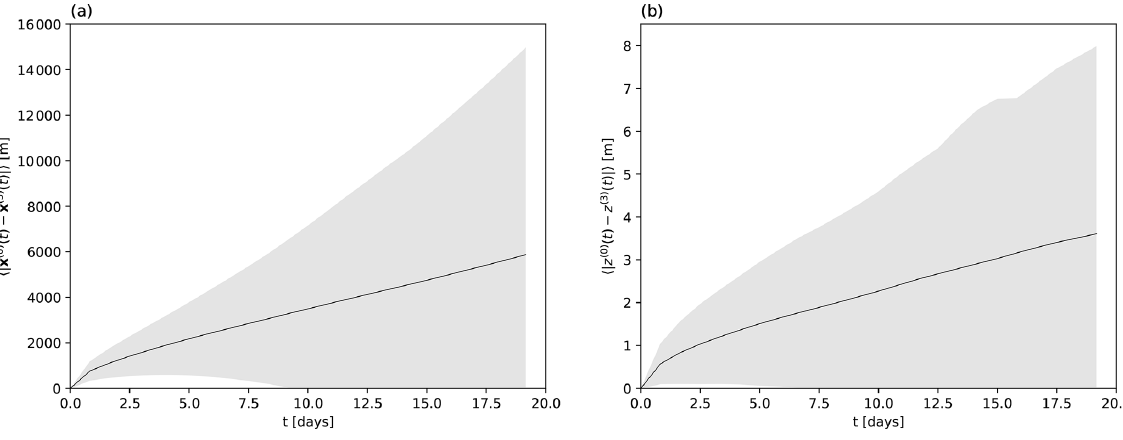
Figure B2. Same as Fig. B1 for the comparison of Eqs. (1) and